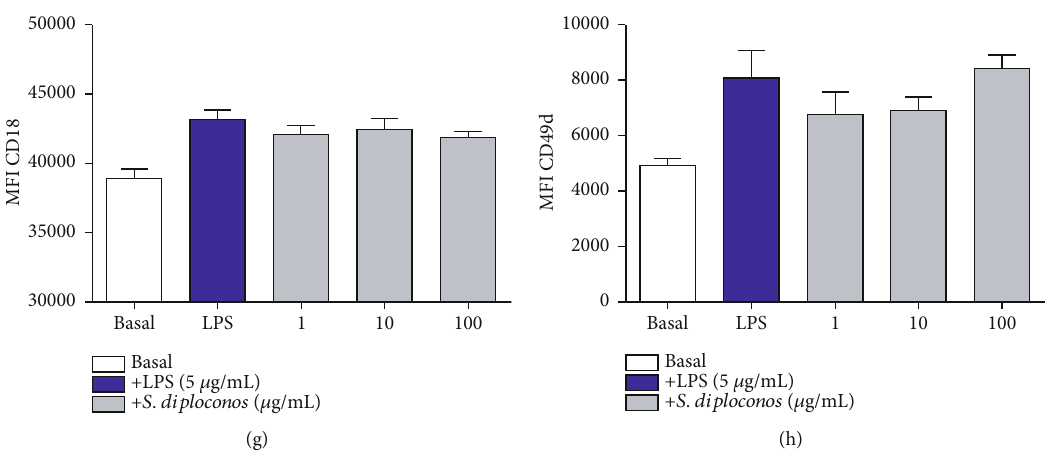
Figure 2: E ff ects of the S. diploconos fruit extract on neutrophils. Neutrophils obtained from the peritoneal cavity of Swiss mice (1% oyster glycogen) were incubated in the presence or absence of LPS (5 μ g/mL) and with S. diploconos (1, 10, or 100 μ g/mL). Nitrite levels were measured by the Griess reaction (a). The levels of (b) TNF α , (c) IL-1 β , and (d) IL-6 were determined by ELISA. For the chemotaxis assay (e), a neutrophil suspension ( 1 × 10 7 ) was incubated with di ff erent concentrations of S. diploconos (1, 10, or 100 μ g/mL) for 15 minutes and placed in front of the fMLP (1 μ M) on an agarose plate. Quanti fi cation was made from the margin of the peripheral perforations towards the chemotactic agent (central perforation). Neutrophils ( 1 × 10 6 ) were incubated in the presence or absence of LPS (5 μ g/mL) along with S. diploconos (1, 10, or 100 μ g/mL) for evaluation of the neutrophil adhesion molecules. Adhesion molecule expression was assessed by labeling with (f) CD62L, (g) CD18, and (h) CD49 detection antibodies by fl ow cytometry. Values express the mean ± SEM of tests performed with cells obtained from 8 animals per group. ∗ p < 0 : 05 ; ∗∗ p < 0 : 01 ; ∗∗∗ p < 0 : 001 ; and ∗∗∗∗ p < 0 : 0001 vs. the LPS group signi fi cantly di ff erent from the basal group #### p < 0 : 0001 (one-way ANOVA followed by Turkey ’ s post hoc